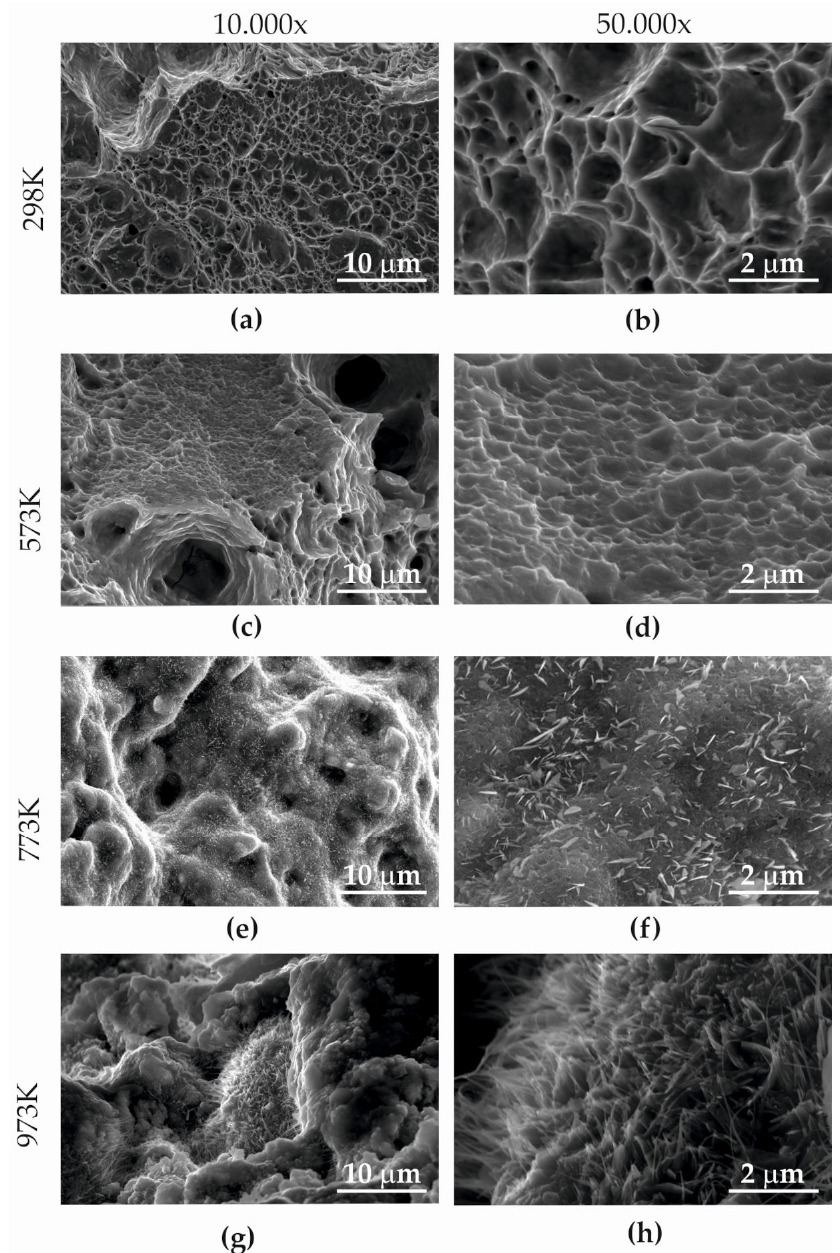
Figure 14. Microfractography of Armstal 550 separating fracture surfaces after static tensile tests at various temperatures: ( a , b ) 298 K; ( c , d ) 573 K; ( e , f ) 773 K; ( g , h ) 973 K.